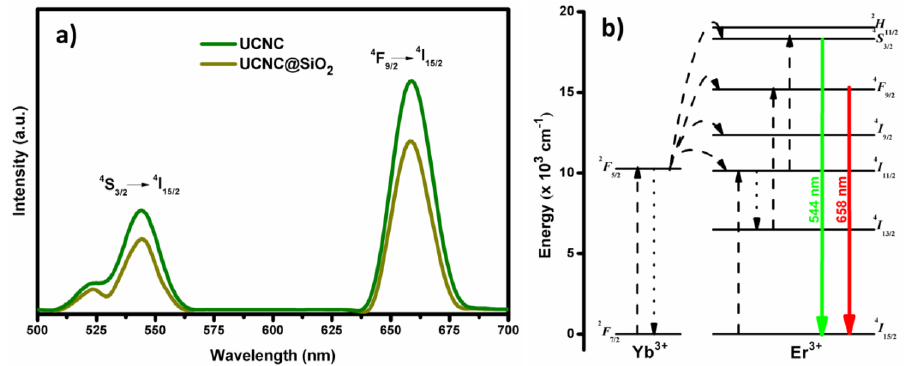
Figure 4. Upconversion luminescence spectra of ( a ) NaYF 4 :Yb/Er and silica-coated excited at 980nm and ( b ) Schematic illustration of lanthanide ions (Yb 3+ , Er 3+ ) energy transitions in NaYF 4 :Yb/Er nanocrystals.